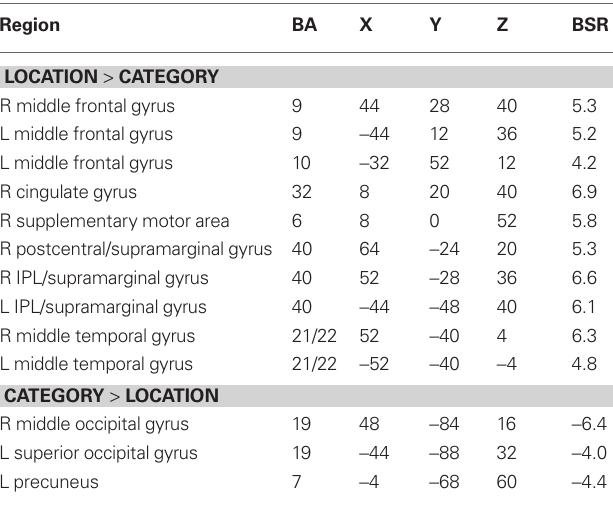
S and S D ) and working memory study (i.e., overlap of areas seen S L S L